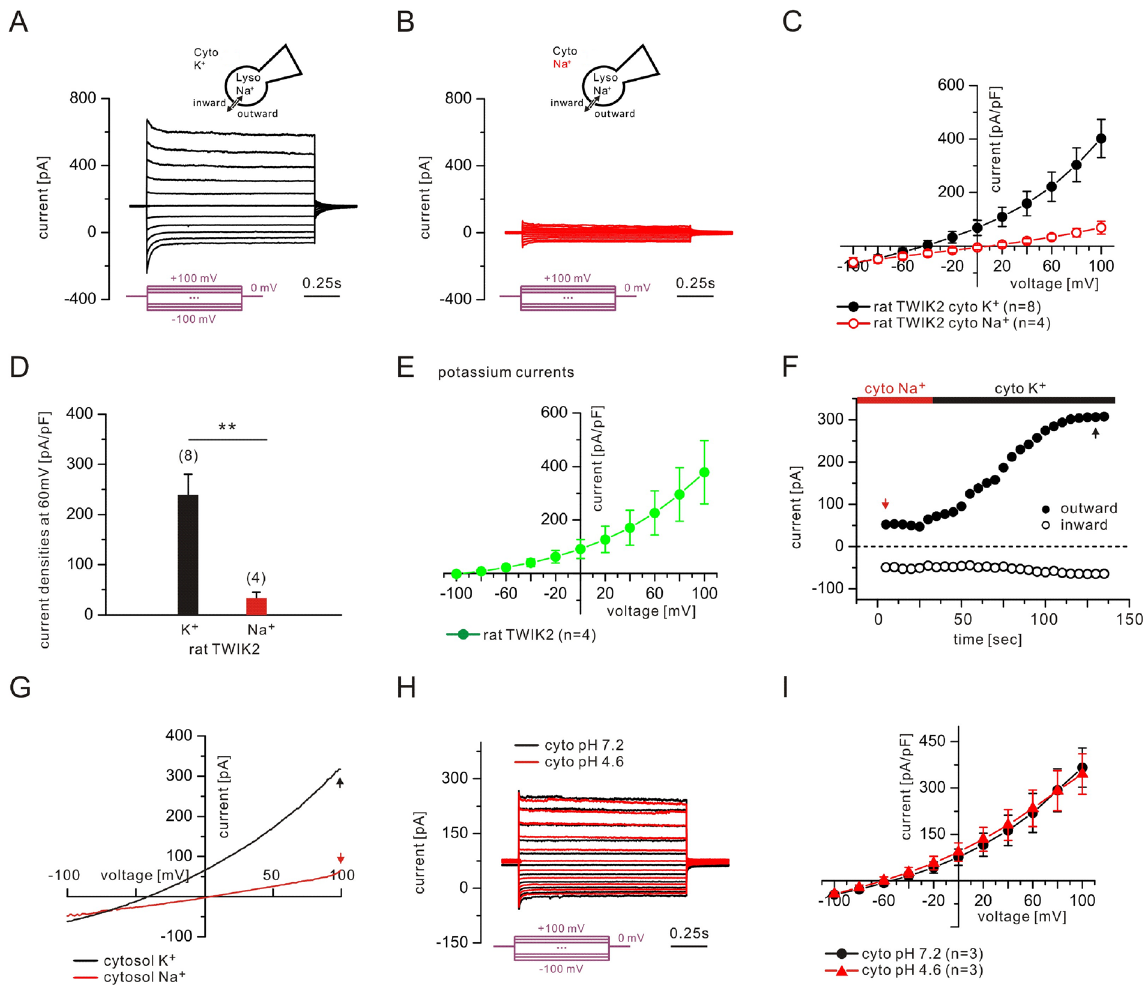
Figure 3. TWIK2 currents in endolysosomes. Endolysosomal currents were recorded from HEK293T cells expressing rat TWIK2. ( A) Currents recorded using a high K + -containing bath solution (145 mM K + , pH 7.2). Step protocols from − 100 to + 100 mV with a 20 mV step were applied from a holding potential of 0 mV. (B) Currents recorded using a high Na + -containing bath solution (145 mM Na + , pH 7.2). Same step protocol as in ( A ). (C) I-V relationships constructed from the currents recorded in ( A ) and ( B ). (D) Averaged current densities at 60 mV. (E) Potassium I-V curves (defined as − + + I I ). (F) Representative cyto high K cyto high Na continuous recordings using ramp protocols ( − 100 mV to + 100 mV in 500 ms, every 5 s, from a holding potential of 0 mV). (G) Recordings at time points (black and red arrows) in ( F) were used for the I-V relationships. (H) Current recorded at cytosolic pH 7.4 and pH 4.6. Outward current denotes flow of positive charge into the lumen (pipette) from the cytosol (bath). Numbers of patched endolysosomes are shown in parentheses. Data are represented as mean ± s.e.m. Same step protocol as in ( A ). (I) I-V relationships constructed from the currents recorded in ( H